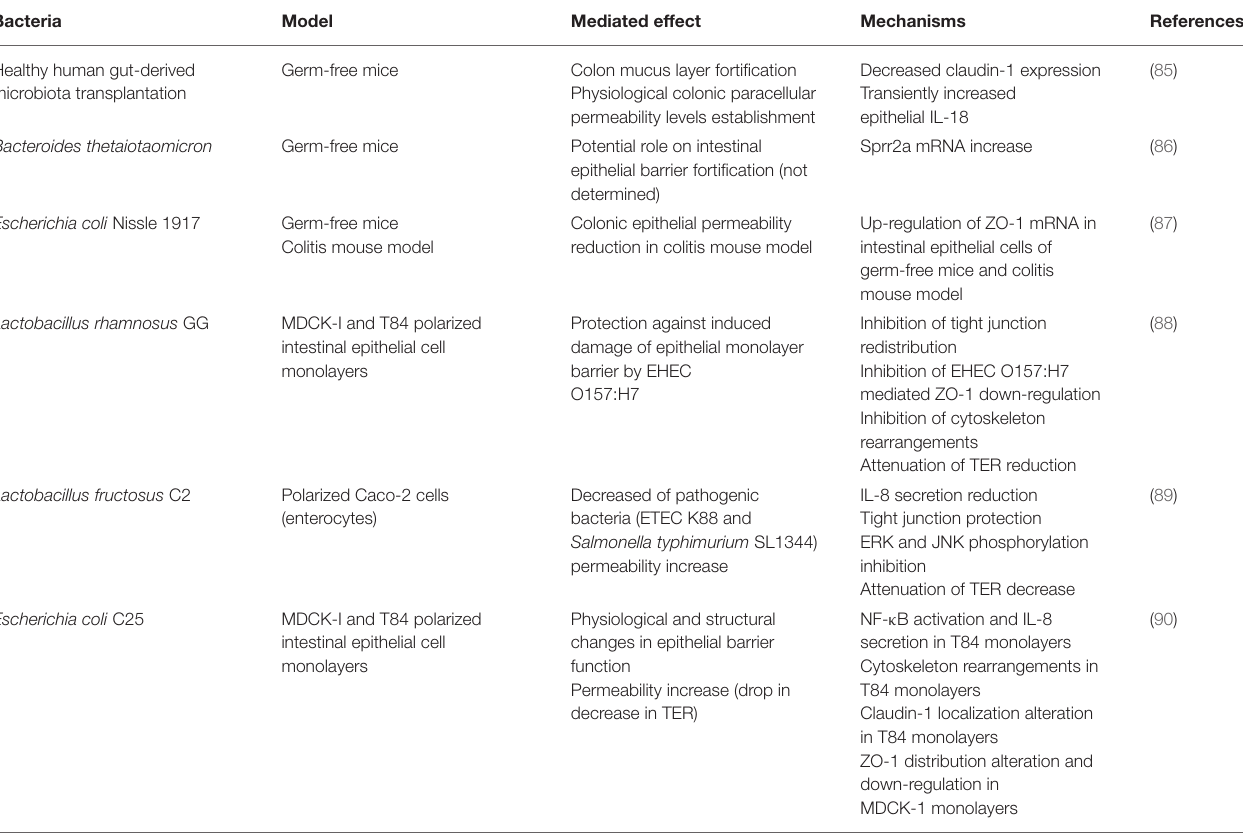
TABLE 2 | Some evidences of the impact of bacteria on intestinal epithelial barrier functions and integrity.